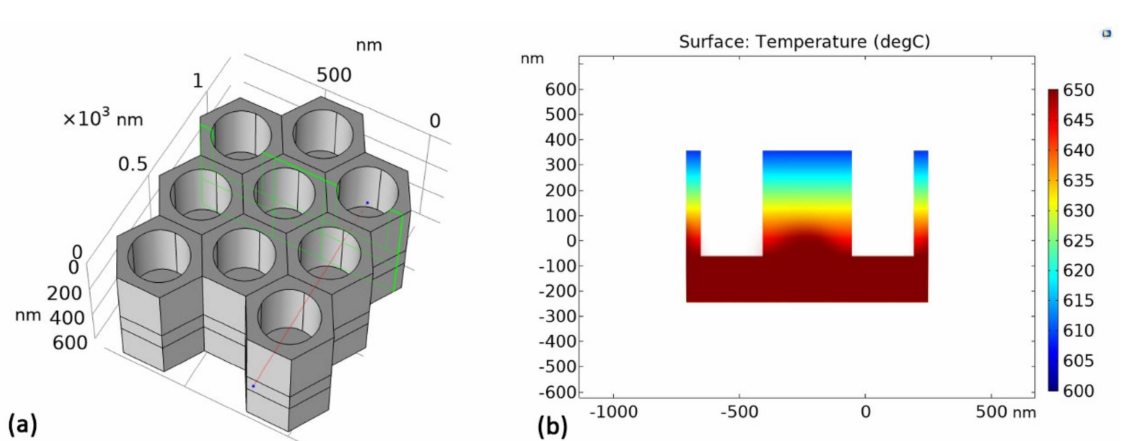
Figure 8. ( a ) Cut plane of honeycomb hexagonal structure along z -axis presented by green surface. ( b ) Internal surface temperature distribution in °C of honeycomb along the z -axis from GaN to Cu–Ni alloy